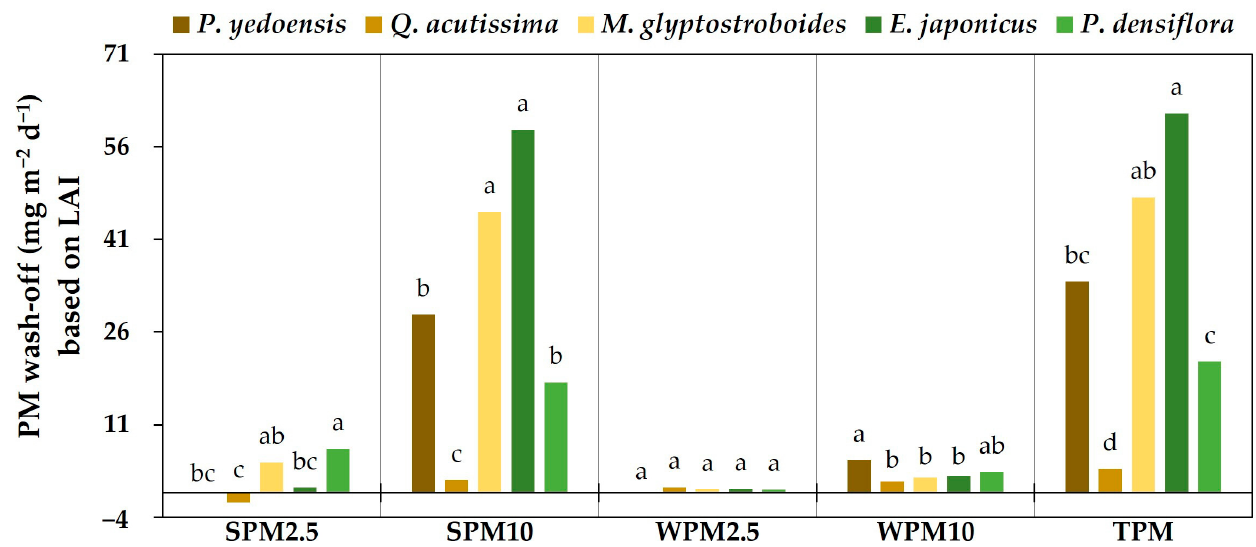
Figure 3. Net PM wash-off ability during rainfall events on surface PM (SPM2.5, SPM10), in-wax PM (WPM2.5, WPM10), and total PM (TPM) from the entire tree crown based on the LAI. Different letters above bars represent significant difference among species in each PM particle size fraction at p ≤ 0.05 using Tukey’s HSD multiple comparisons. Data are mean, n = 10. 3.2. Interspecific Trends in Variations of PM Adsorption in Surfaces and Wax Layers of Inner and Outer Crown Leaves before and after Rainfall Events As shown in Figure S1, positive and negative changes in leaf surface and in-wax PM particles after different rainfall intensities for five tree species were represented as cate- gorical data and presented as percentages (i.e., PM retention (+) and wash-o ff ( − ) pro- cesses). There were no statistically significant changes in PM mass for E. japonicus ( t = − 1.598 and p = 0.142), P. yedoensis ( t = − 1.835 and p = 0.083), and Q. acutissima ( t = − 0.878 and p = 0.391) after light rainfall intensity. More importantly, PM retention effects were observed in P. densiflora ( t = 5.004 and p = 0.000) and M. glyptostroboides ( t = 3.317 and p = 0.004) after light rainfall intensity. Under moderate rainfall intensity, P. densiflora was found to have significant wash-o ff levels of − 57% ( t = − 5.613 and p = 0.000) in PM mass, whereas Q. acutissima showed significantly higher PM mass ( t = 3.383 and p = 0.003), clearly indicating that the retention of PM particles continually occurred throughout the rainfall record period. For heavy rainfall intensity, wash-off levels for both leaf surface and in-wax PM were found to be significantly higher in E. japonicus ( t = − 7.429 and p = 0.000), M. glyptostroboides ( t = − 6.207 and p = 0.000), P. densiflora ( t = − 3.852 and p = 0.001), and P. yedoensis ( t = − 10.344 and p = 0.000), except for Q. acutissima ( t = − 0.173 and p = 0.865). 3.3. Determination of Leaf Microstructure and Surface Roughness The micromorphological, morphological, and 3D topography images of the leaf sur- faces of each tree species are shown in Figure 4 and 5, respectively. For the studied tree species, the dominant surface structure was rough, indicating the existence of grooves, trichomes, stomata, and waxy cuticles (Figure 4–6). Grooves occurred on the adaxial sur- faces of M. glyptostroboides and P. yedoensis , especially relatively striped deep grooves along the leaf vein for M. glyptostroboides (Figure 4a,b). M. glyptostroboides showed high roughness with deep grooves and densely distributed wax crystals on both leaf surfaces with no trichome (Figure 4a–c and 5a,b). In P. yedoensis , hairy trichomes were distributed on leaf blades or concentrated along veins (especially abaxial leaf surfaces), and leaf roughness was similar for both leaf surfaces (Figure 4d–f and 5c,d). Among the studied tree species, Q. acutissima showed non-glandular and stellate trichomes on leaf blades of abaxial leaf surfaces (Figure 4g–i and 5e,f) and had the lowest wax and surface roughness